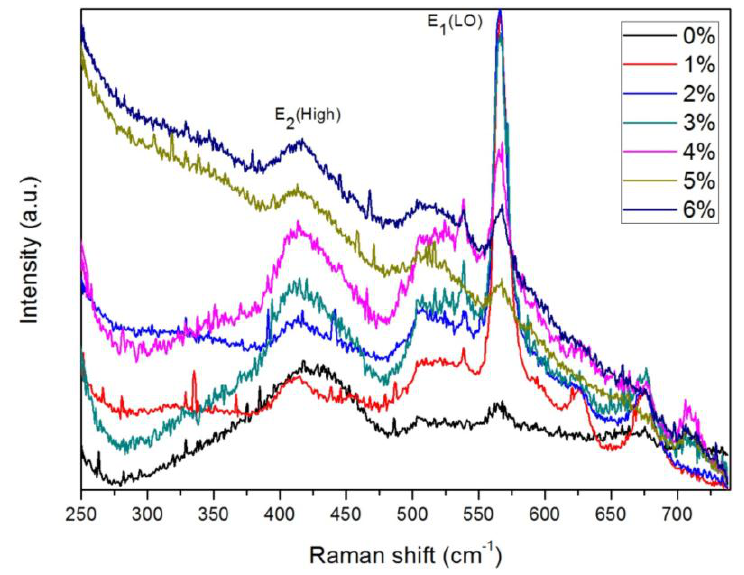
Figure 4. Raman spectra of Cu x Zn 1− x O ( x = 0–0.06).